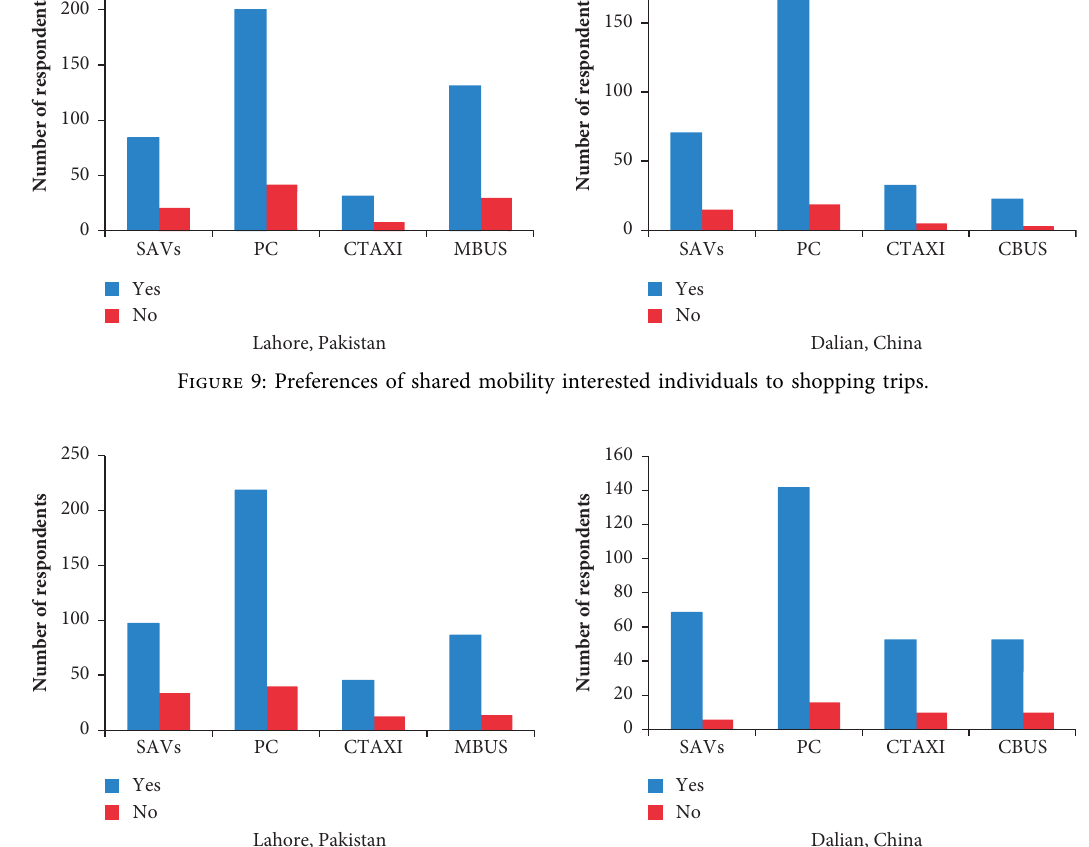
Figure 10: Preferences of shared mobility interested individuals to social